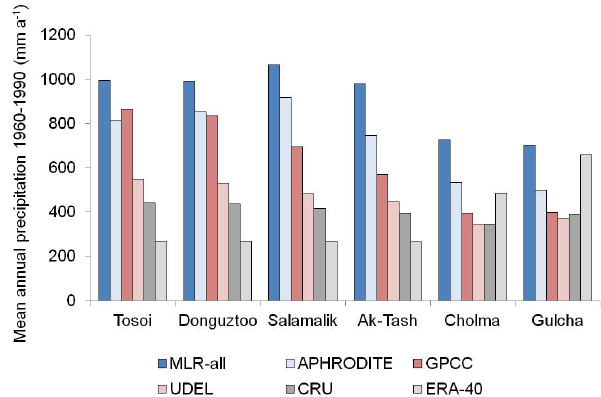
Fig. 7. Mean annual precipitation (1960–1990) for 6 subcatchments of the Karadarya Basin for the precipitation data sets MLR-all, APHRODITE and four global precipitation data